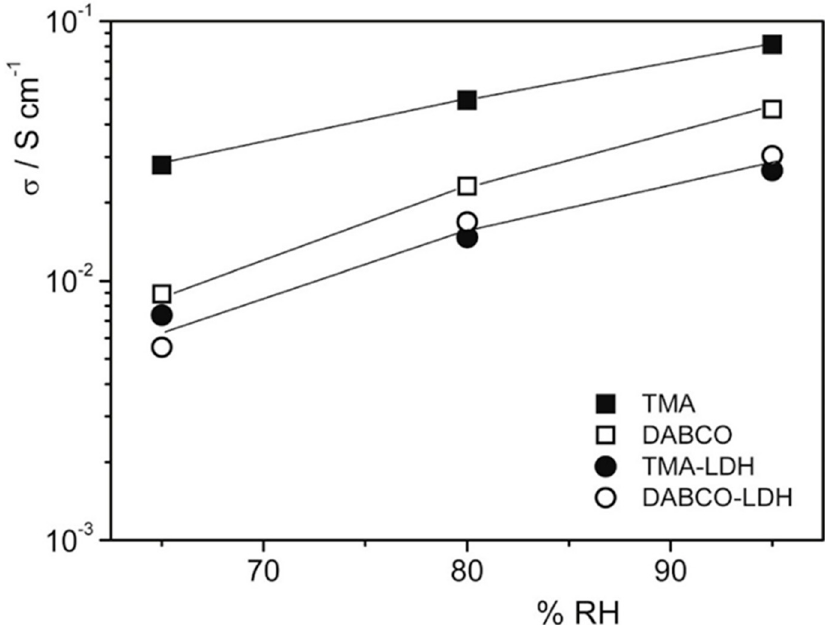
Figure 6. Conductivity measurements at 60 °C as a function of RH% of membranes after treatment at 25 °C in 2 M KOH for 24 h. Reproduced with permission from Ref.